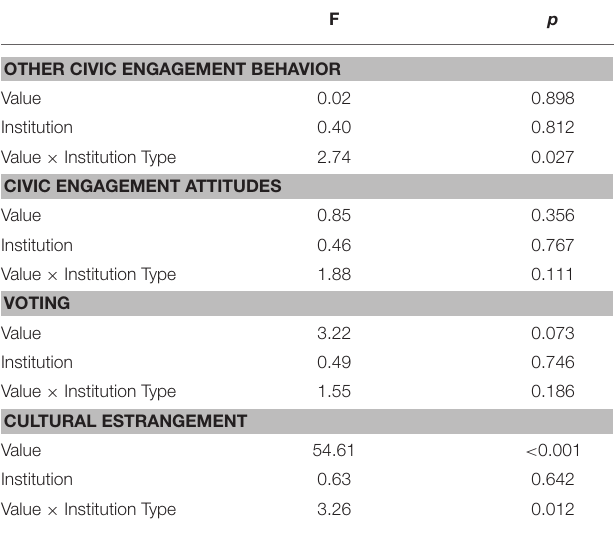
TABLE 3 | Test statistics from predicting cultural estrangement and civic engagement behaviors and attitudes from perceived values encouraged by institutions, institution types, and their interaction, Study